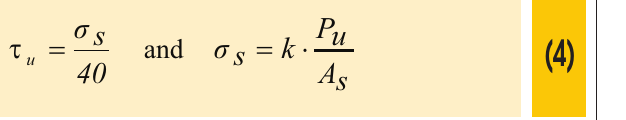
Figure 8 – Numerical approaches of the experimental tests for SCC1 and